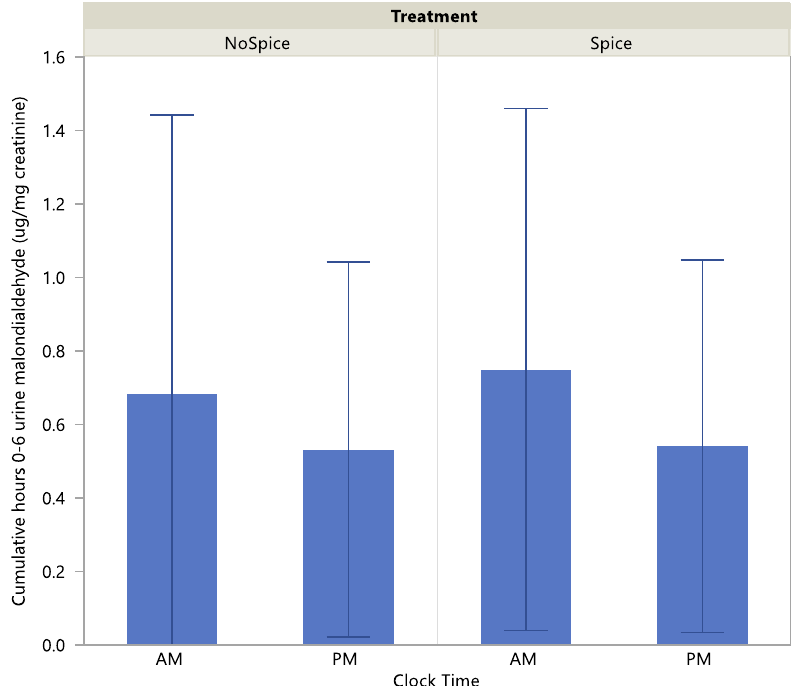
Figure 5. Cumulative hours 0–6 urine malondialdehyde by treatment and clock time. Effect of clock time, p < 0.05; treatment, p > 0.05; clock time x treatment interaction, p > 0.05.